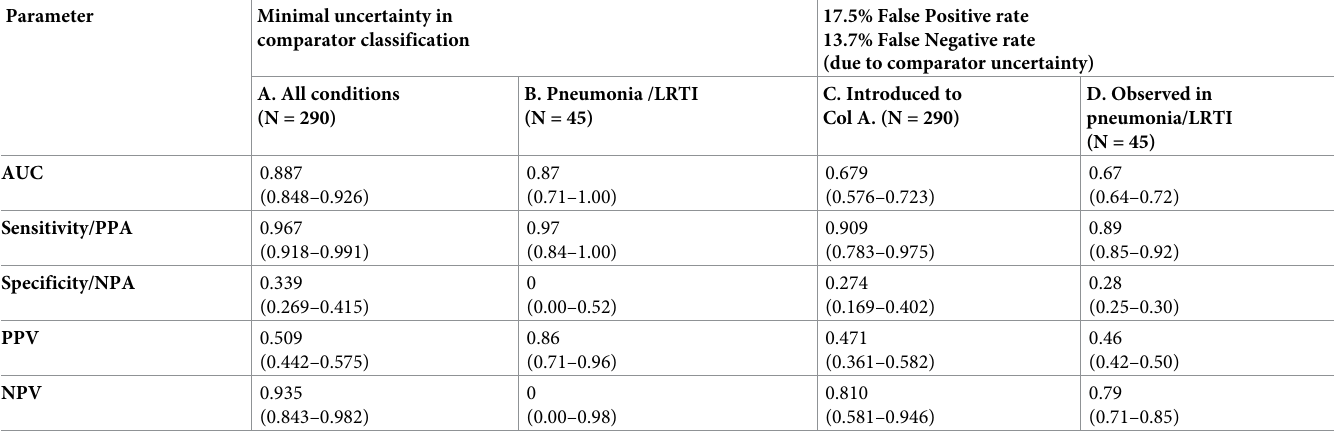
Table 4. Demonstration of the effect of comparator uncertainty on estimates of test performance, for the pneumonia/LRTI patient subset.